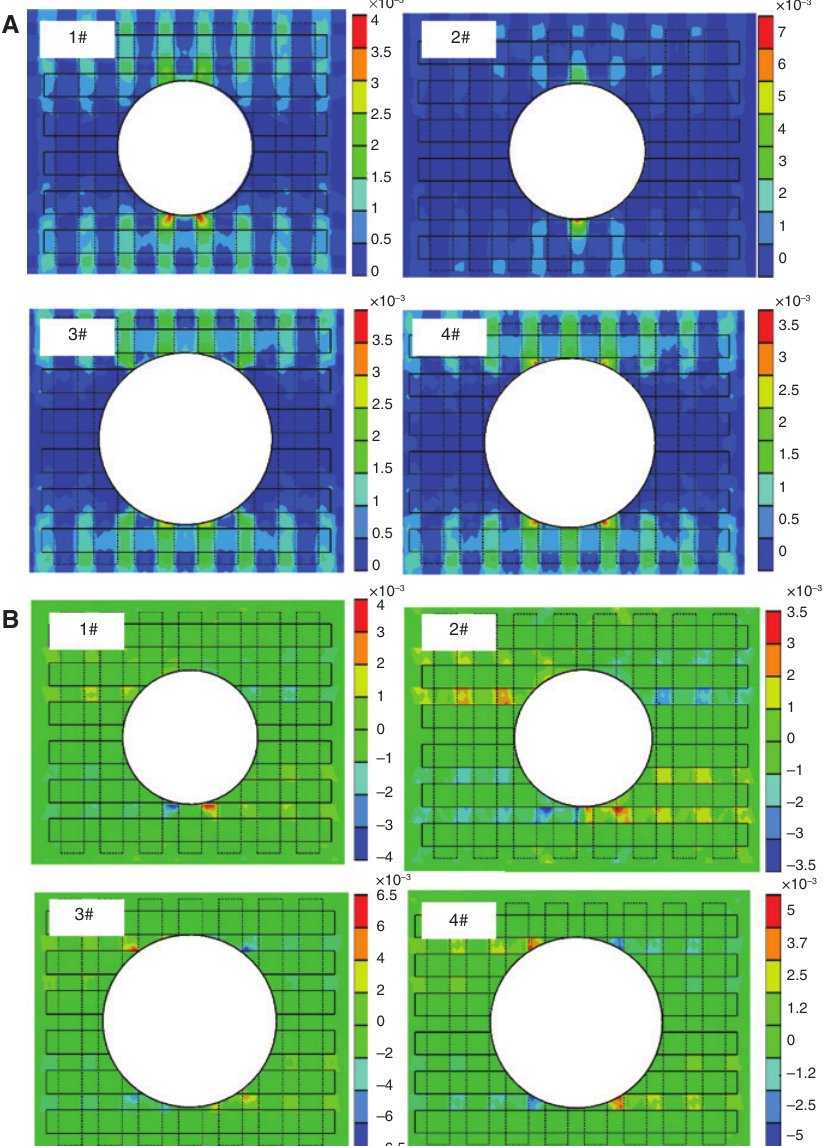
and (B) γ of 0 ° ply (solid lines for 1-direction fiber yarn and dash lines for 2-direction 11 12